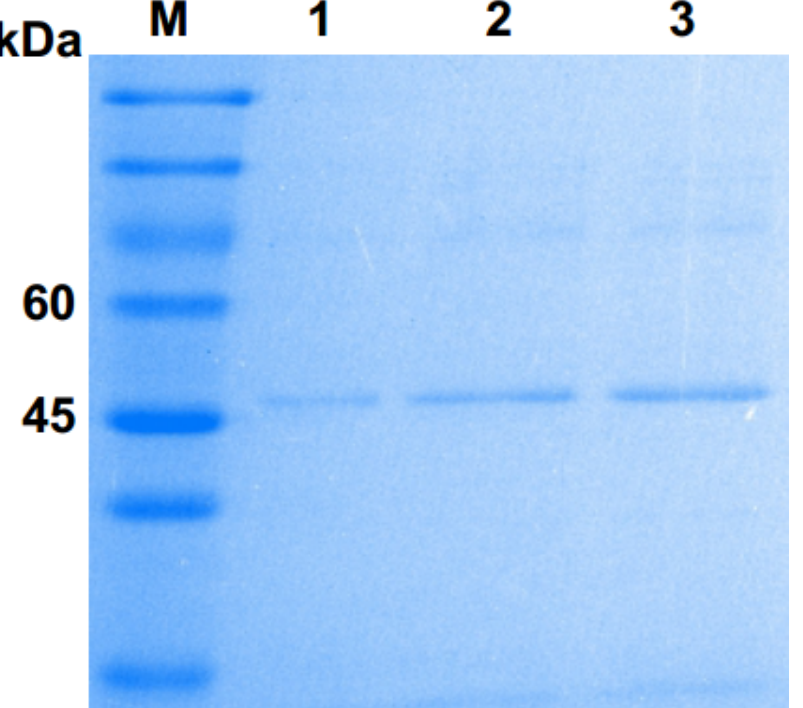
Figure 1. Sulphate–polyacrylamide gel electrophoresis (SDS–PAGE) analysis of purified Pgc4